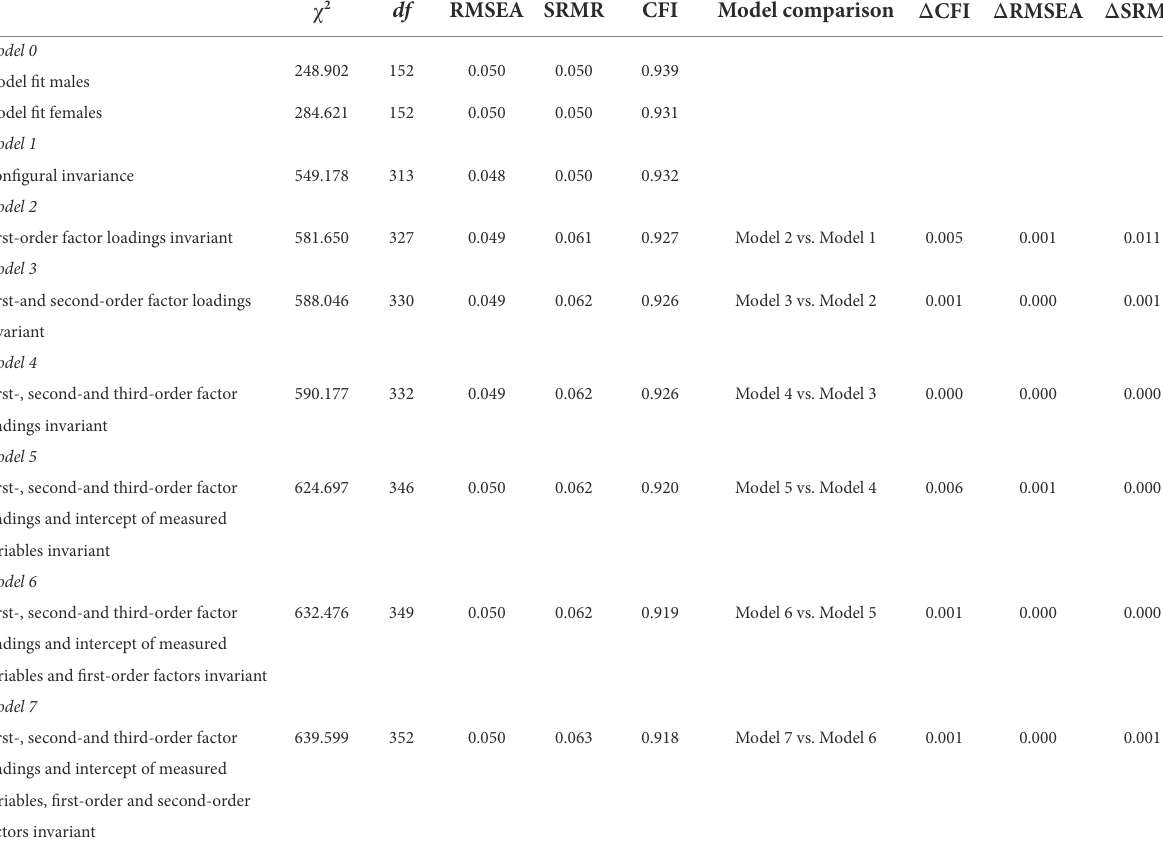
TABLE 2 Summary of fit statistics for testing measurement invariance across gender of third-order factor model of Tempest Self-Regulation Questionnaire for Eating (TESQ-E).